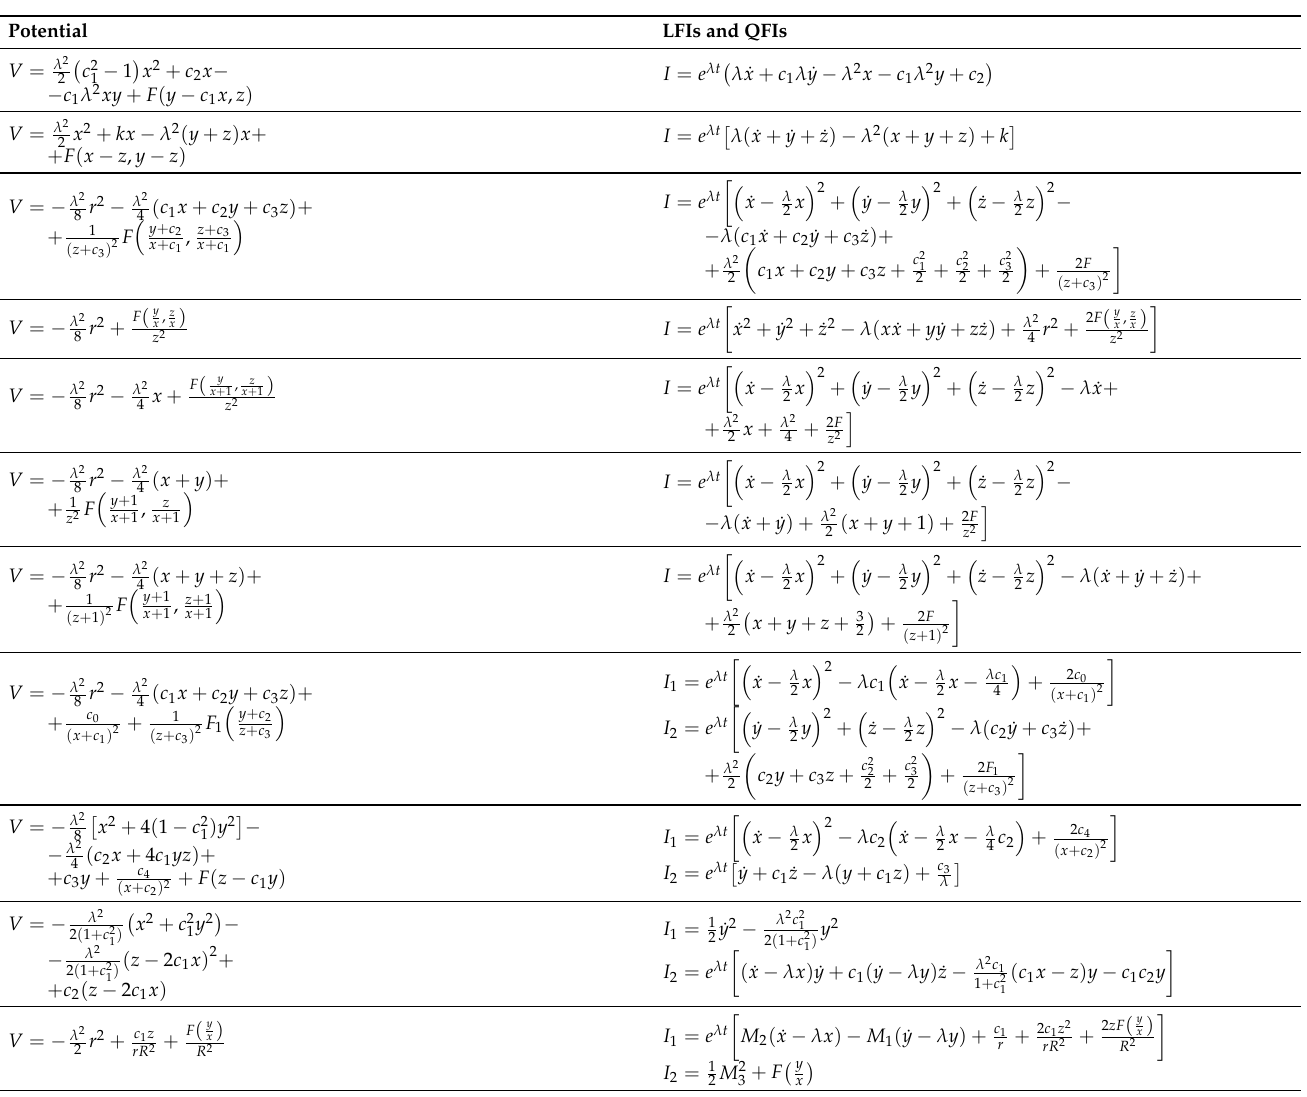
Table 11. Possibly non-integrable potentials V ( x , y , z ) in E 3 that admit time-dependent LFIs/QFIs of